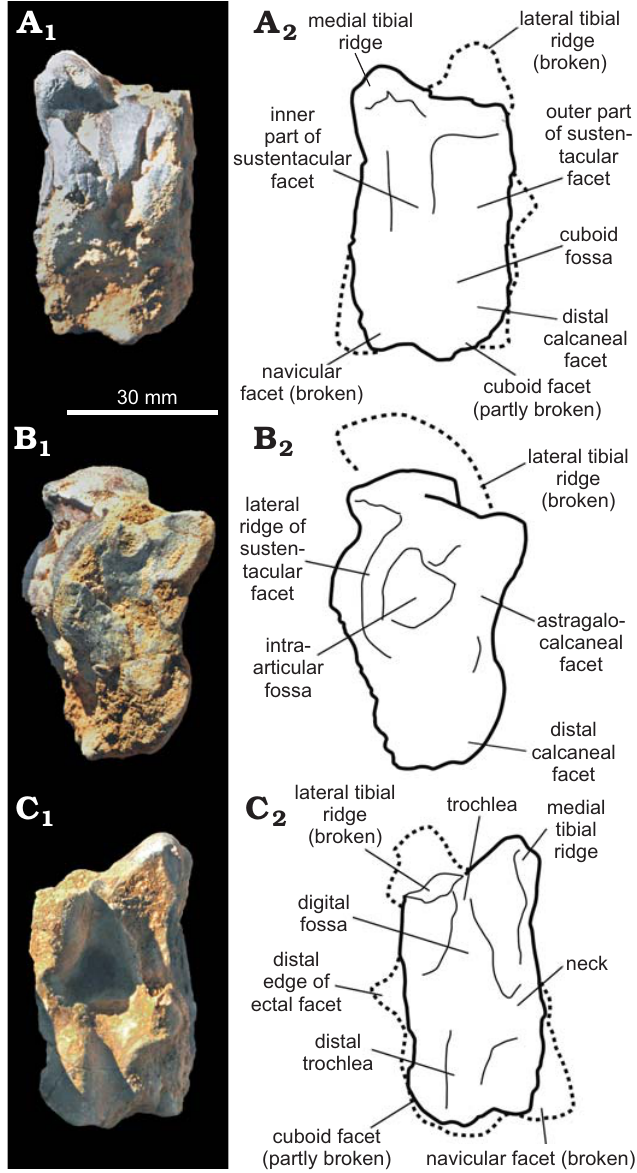
Fig. 10. Right anthracotheriid astragalus, cf. Bothriogenys sp. from the BOTM, early Oligocene, Minqar Tibaghbagh, Qattara Depression, Egypt, in plantar ( A ), lateral ( B ), and dorsal ( C ) views (photographs, A 1 –C 1 ; ex- planatory drawings, A 2 –C 2 ). Missing, reconstructed parts indicated by dot- ted lines. Drawings reconstructed by projection on pictures from Sileem and Hewaidy (2015: fig. 5B2, B4, B1, respectively).